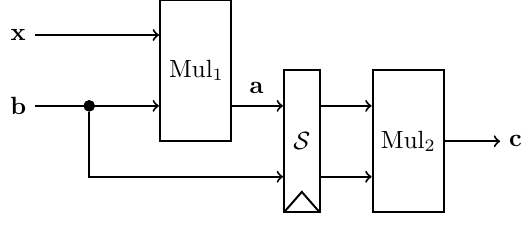
Figure 4: Composition of two UMA